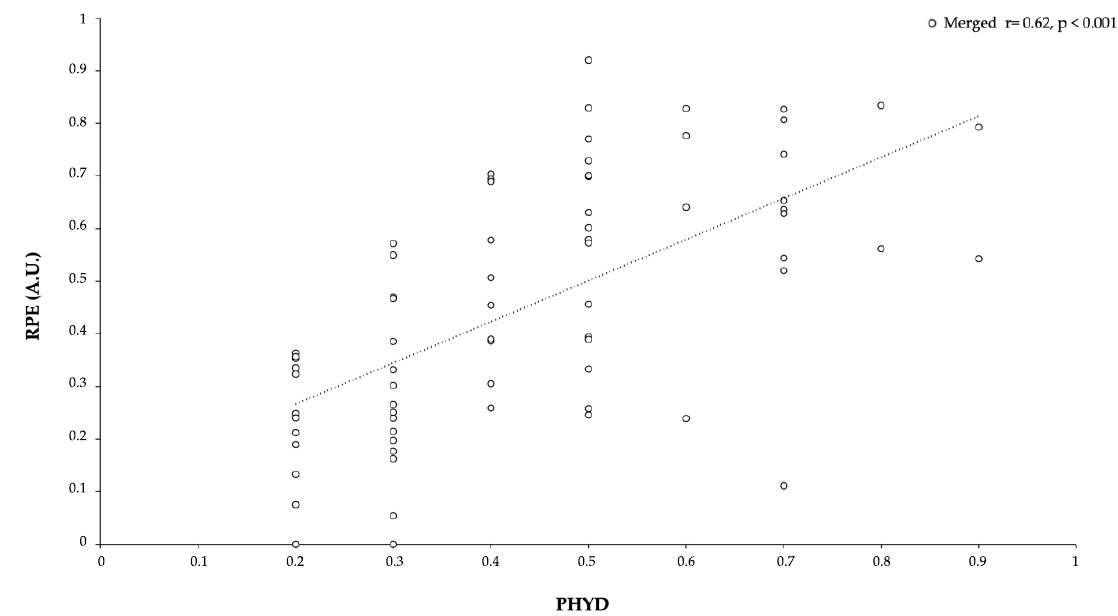
Figure 5. Relationship between PHYD performance and RPE (datasets merged).